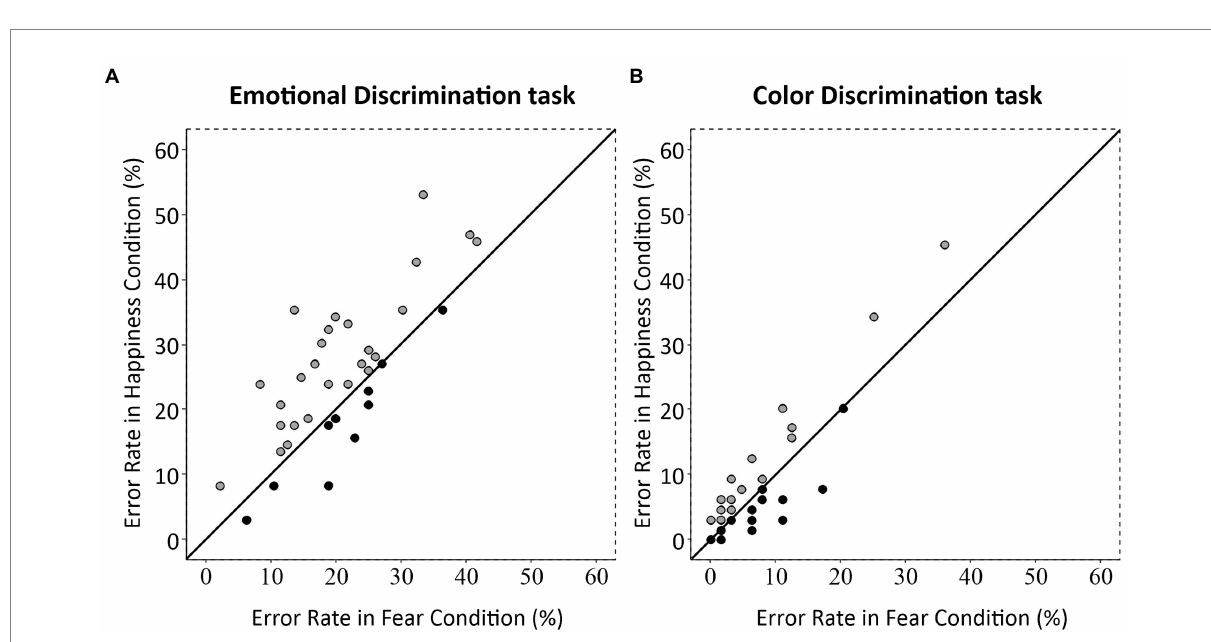
FIGURE 5 Scatterplot of commission errors for happy and fearful postures for each participant in the Emotional and Color Discrimination tasks. Each dot represents one participant. (A) In the Emotional Discrimination task, most of the participants (26/36 or 72%) are located above the first quadrant angle’s bisector, showing a bias towards a higher rate of commission errors for happy than for fearful postures. (B) In the Color Discrimination task, participants are equally distributed above and below the bisector line, indicating a similar commission error rate for the two bodily expressions in the Color Discrimination